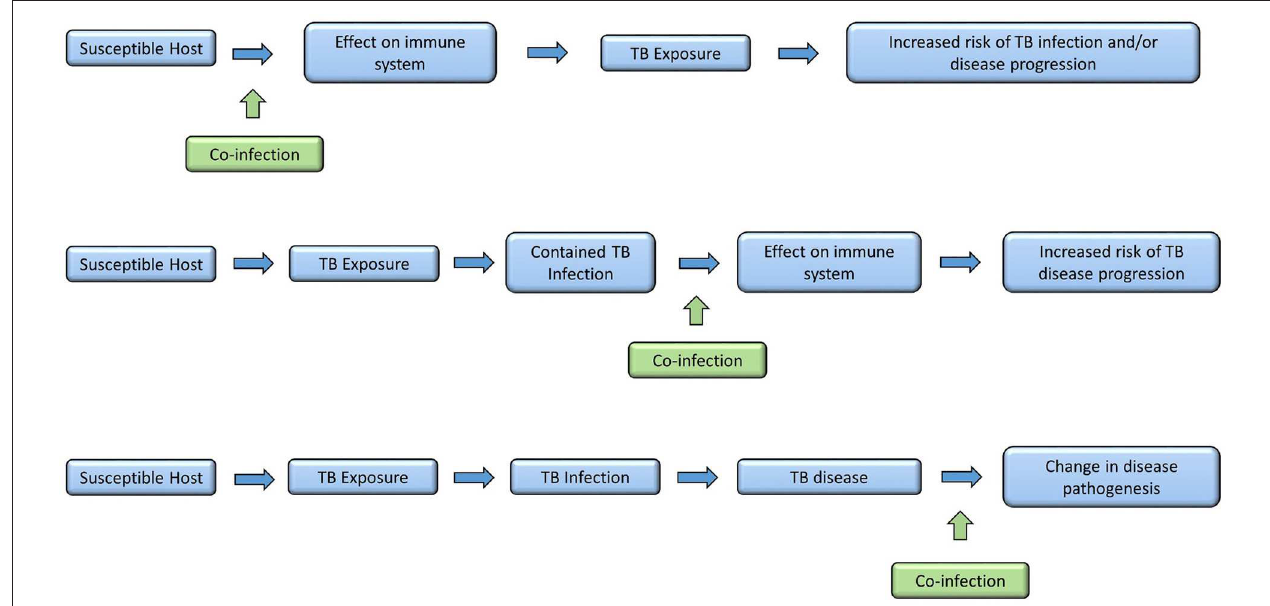
FIGURE 1 | Times in disease spectrum and progression when co-infections may have an influence.